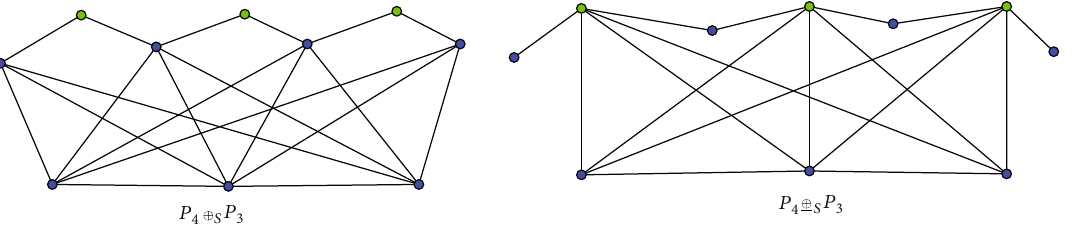
Figure 2: The VSG and ESG of P